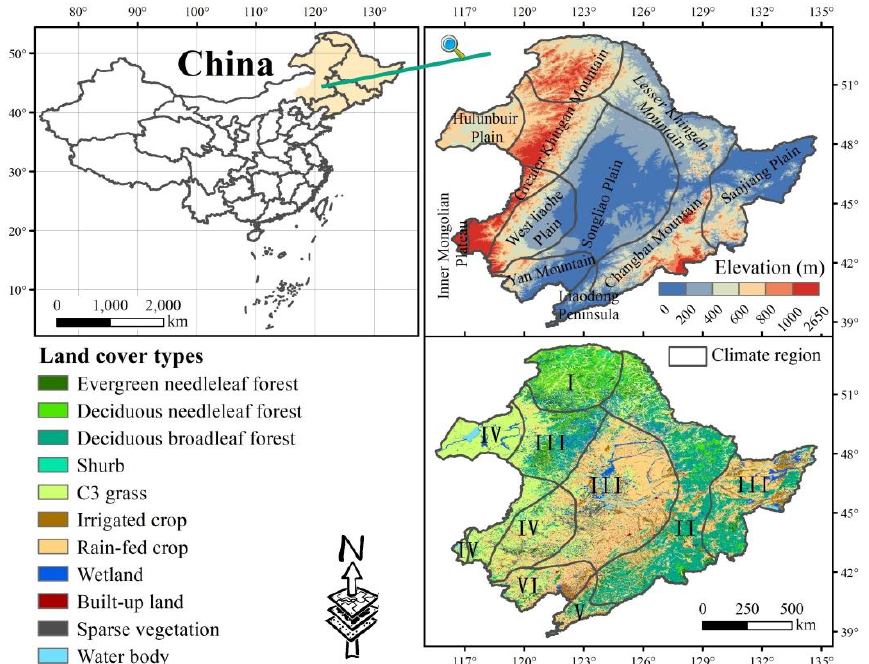
Figure 1. The location, elevation, climate region, and land cover of Northeast China (NEC). The climate regions were based on the climate regionalization in China [31], which includes the cold temperate humid region (C-humid, I), middle temperate humid region (M-humid, II), middle tem- perate sub-humid region (M-sub humid, III), middle temperate semi-arid region (M-semi arid, IV), warm temperate humid region (W-humid, V), and warm temperate sub-humid region (W-sub hu- mid, VI). The criteria of temperature zones and moisture regions in climate regionalization are shown in Table S1. The elevation data in a 30 m spatial resolution were obtained from the Data Center for Resource and Environmental Sciences of Chinese Academy of Sciences (http://www.resdc.cn/, accessed on 11 March 2021).